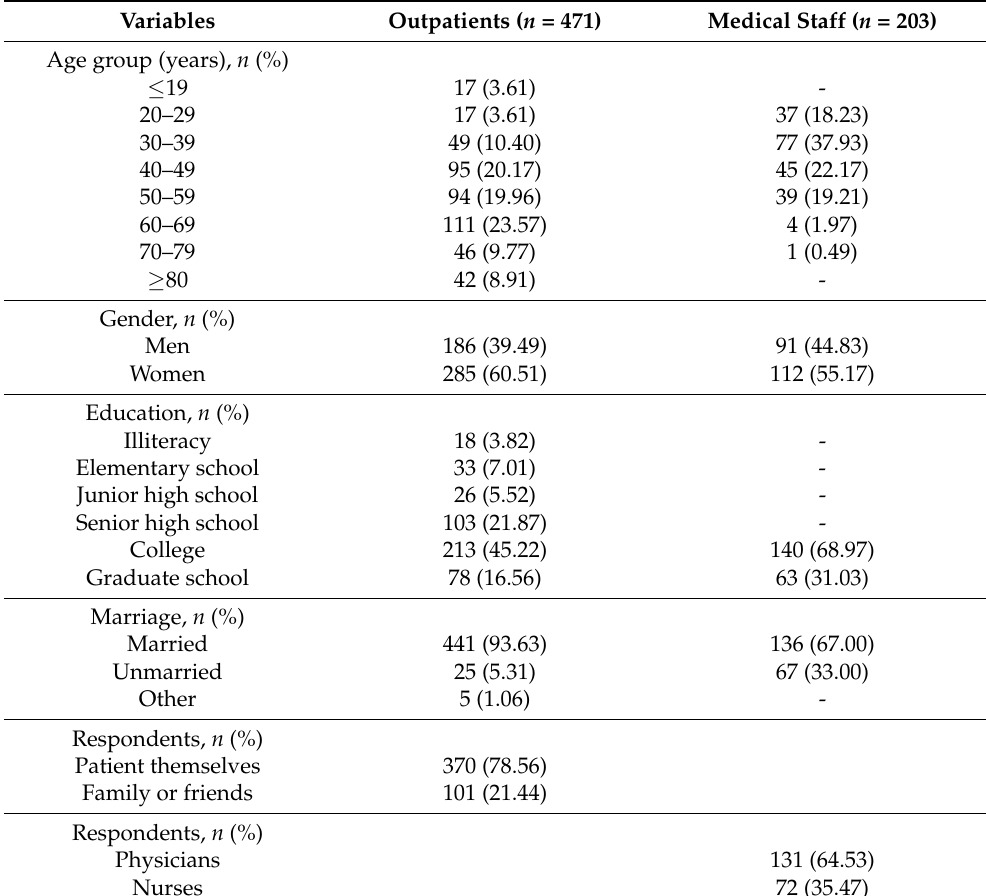
Table 2. Sociodemographic data of the participants who received telephone appointments during the COVID-19 pandemic in